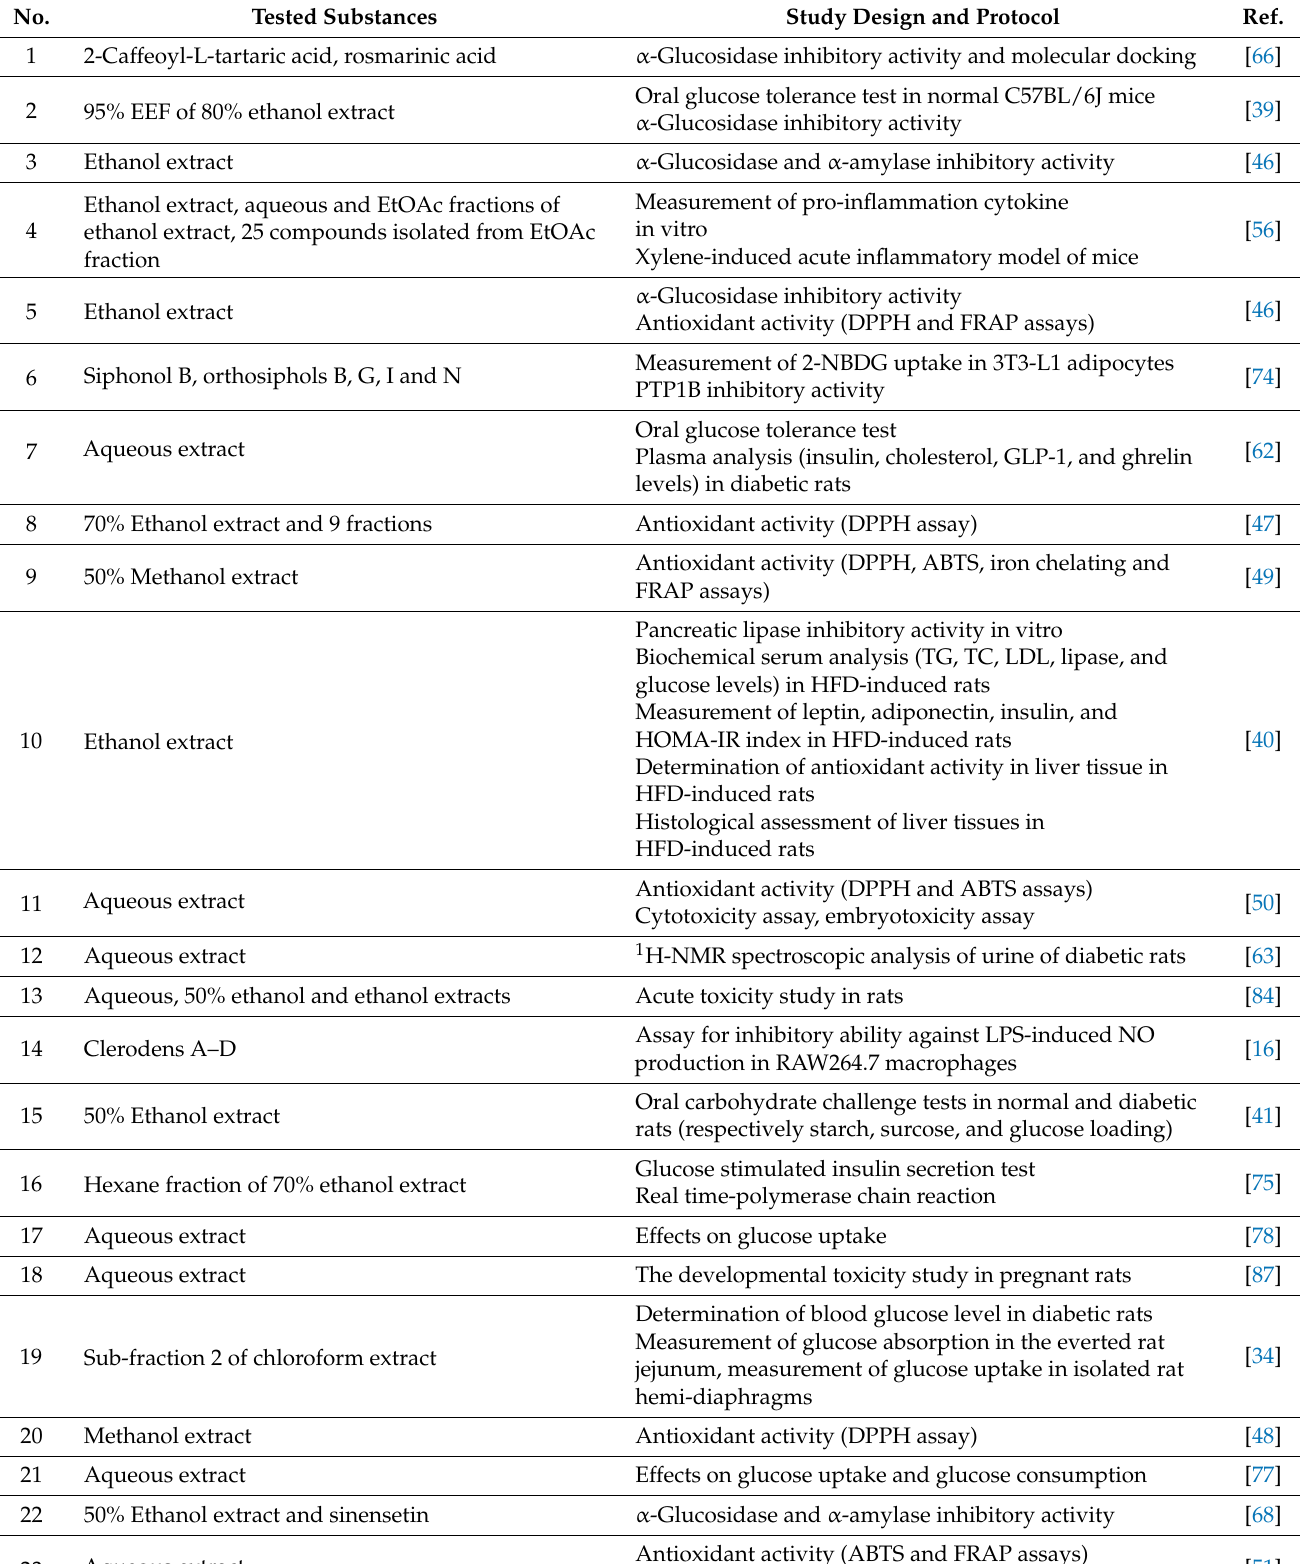
Table 1. Summary of articles reported for antidiabetic effects and toxicity of O. stamineus